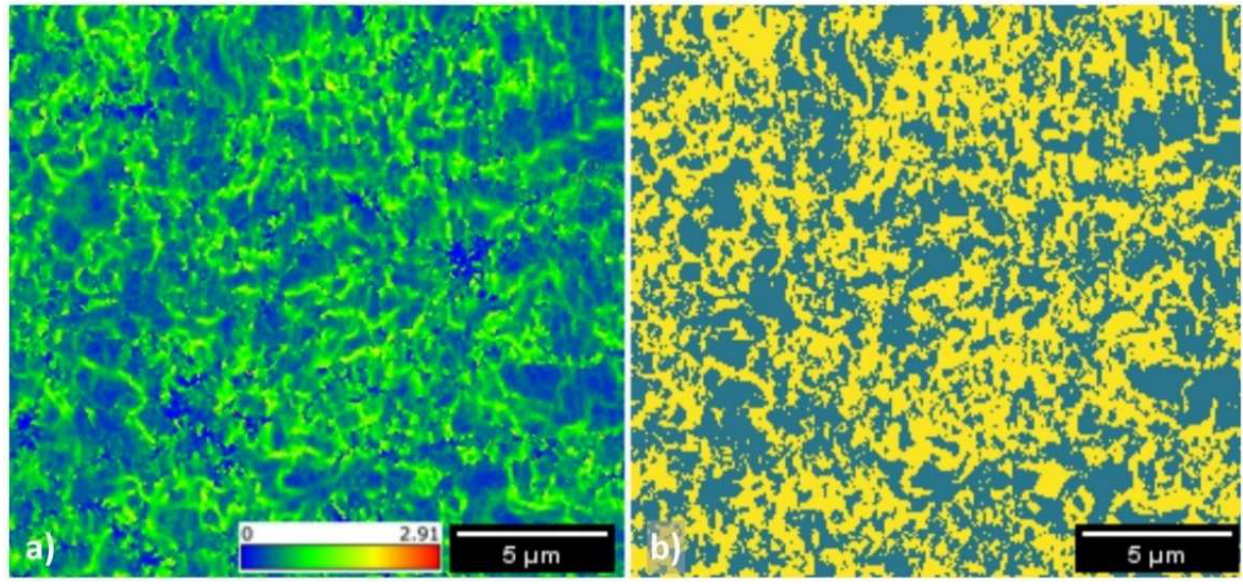
Figure 4. KAM ( a ) as calculated from EBSD detector; and ( b ) after conversion to a binary image using 0.6 as KAM threshold value.